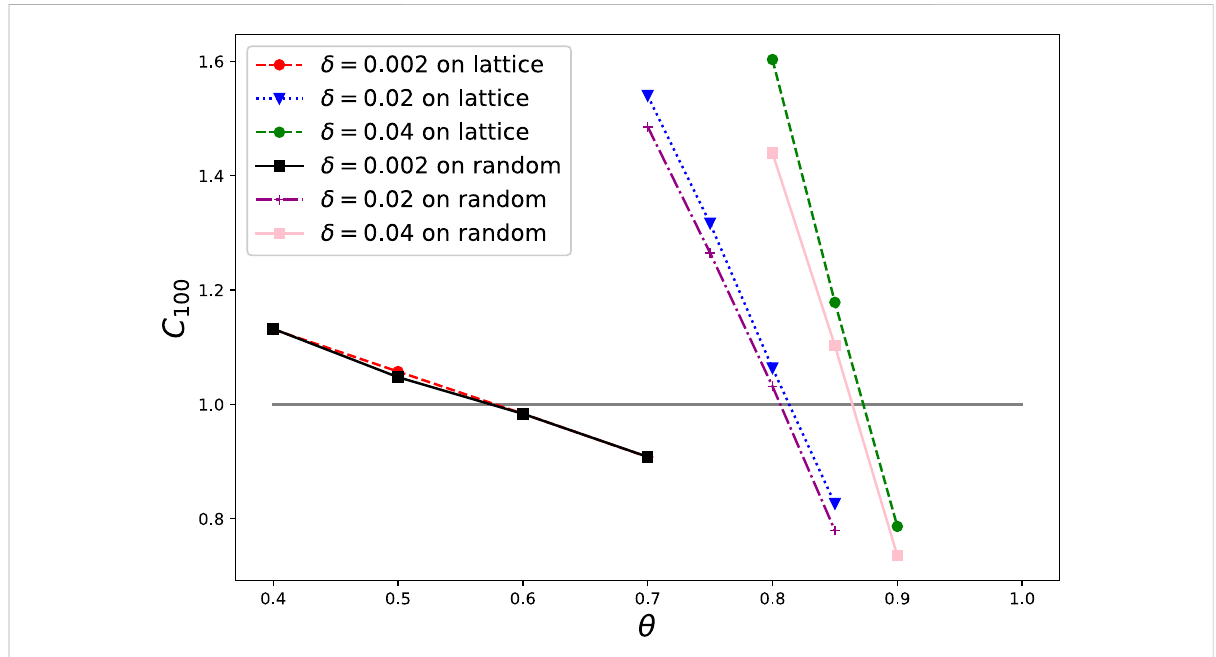
FIGURE 3 Effectofthecon fi dencestructure( θ , δ )ontheconvergenceofopinionsinthe L 2 (two-dimensionallatticegraph)and L r (randomgraph)typesof interaction structure. Because the degree of each individual in the L 2 graph is 4, the parameters were adjusted so that the expected degree in the L r was also 4. Here, the parameters were (| N |, α , β , κ , γ ) = (1,600, 1, 10, 10, 0.0025). The cases of δ = 0.002, 0.02, and 0.04 are shown for each structure type.Thehorizontalaxisindicatesthevalueof θ ,andtheverticalaxisindicatestheaveragevalueof C 100